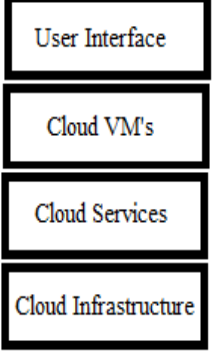
Figure 5 . CloudSim Components